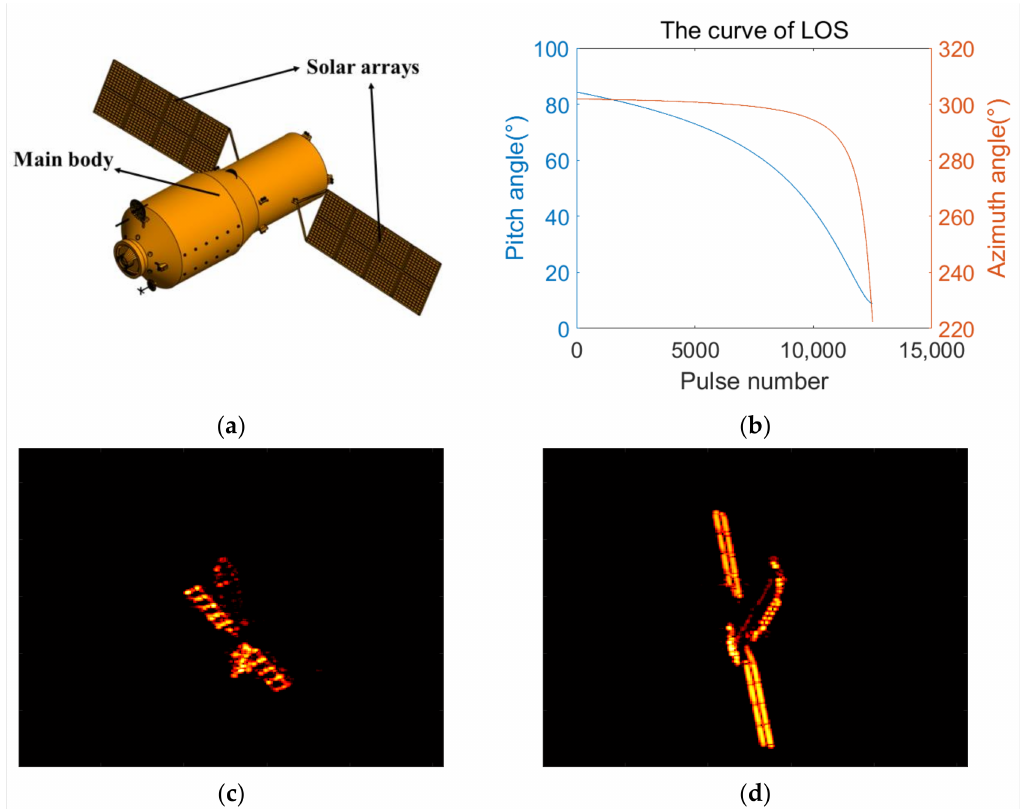
Figure 13. CAD model of Tiangong-1 and corresponding ISAR image sequence: ( a ) CAD model of Tiangong-1, ( b ) the LOS variation curves, and ( c ) and ( d ) the 13th and 24th frames, respectively. The simulated radar is working in X-band and the bandwidth is 2 GHz. The number of frames of ISAR image sequence is 48. The LOS is calculated in STK 11 from the